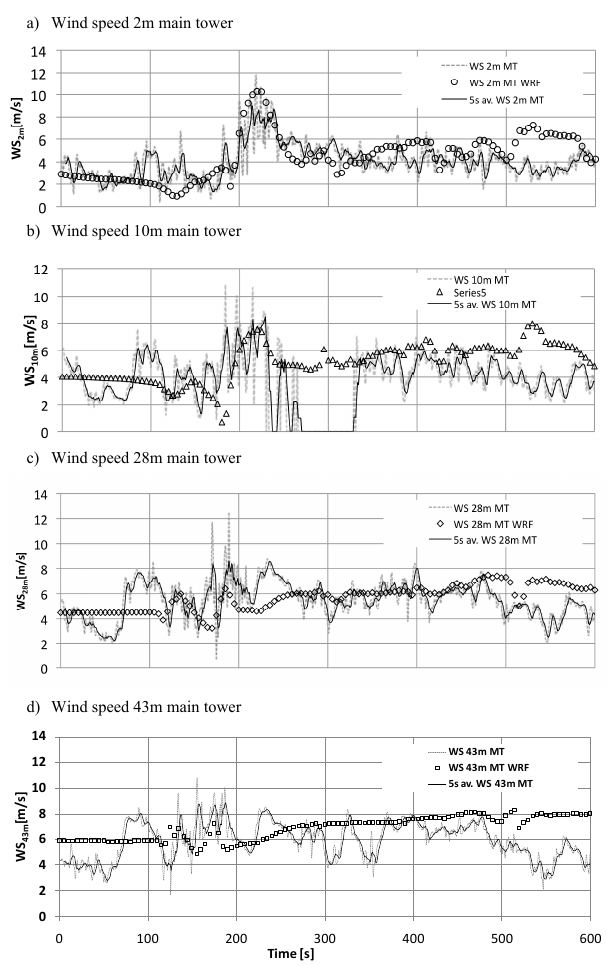
Fig. 8. Time series of horizontal wind speed (WS) at MT levels: (a) 2m, (b) 10m, (c) 28m, and (d) 43m. Gray dashed lines show 1Hz measurements, black solid lines 5s-averaged values, symbols (circle, triangle, diamond, square) model data at the four MT mea- surement